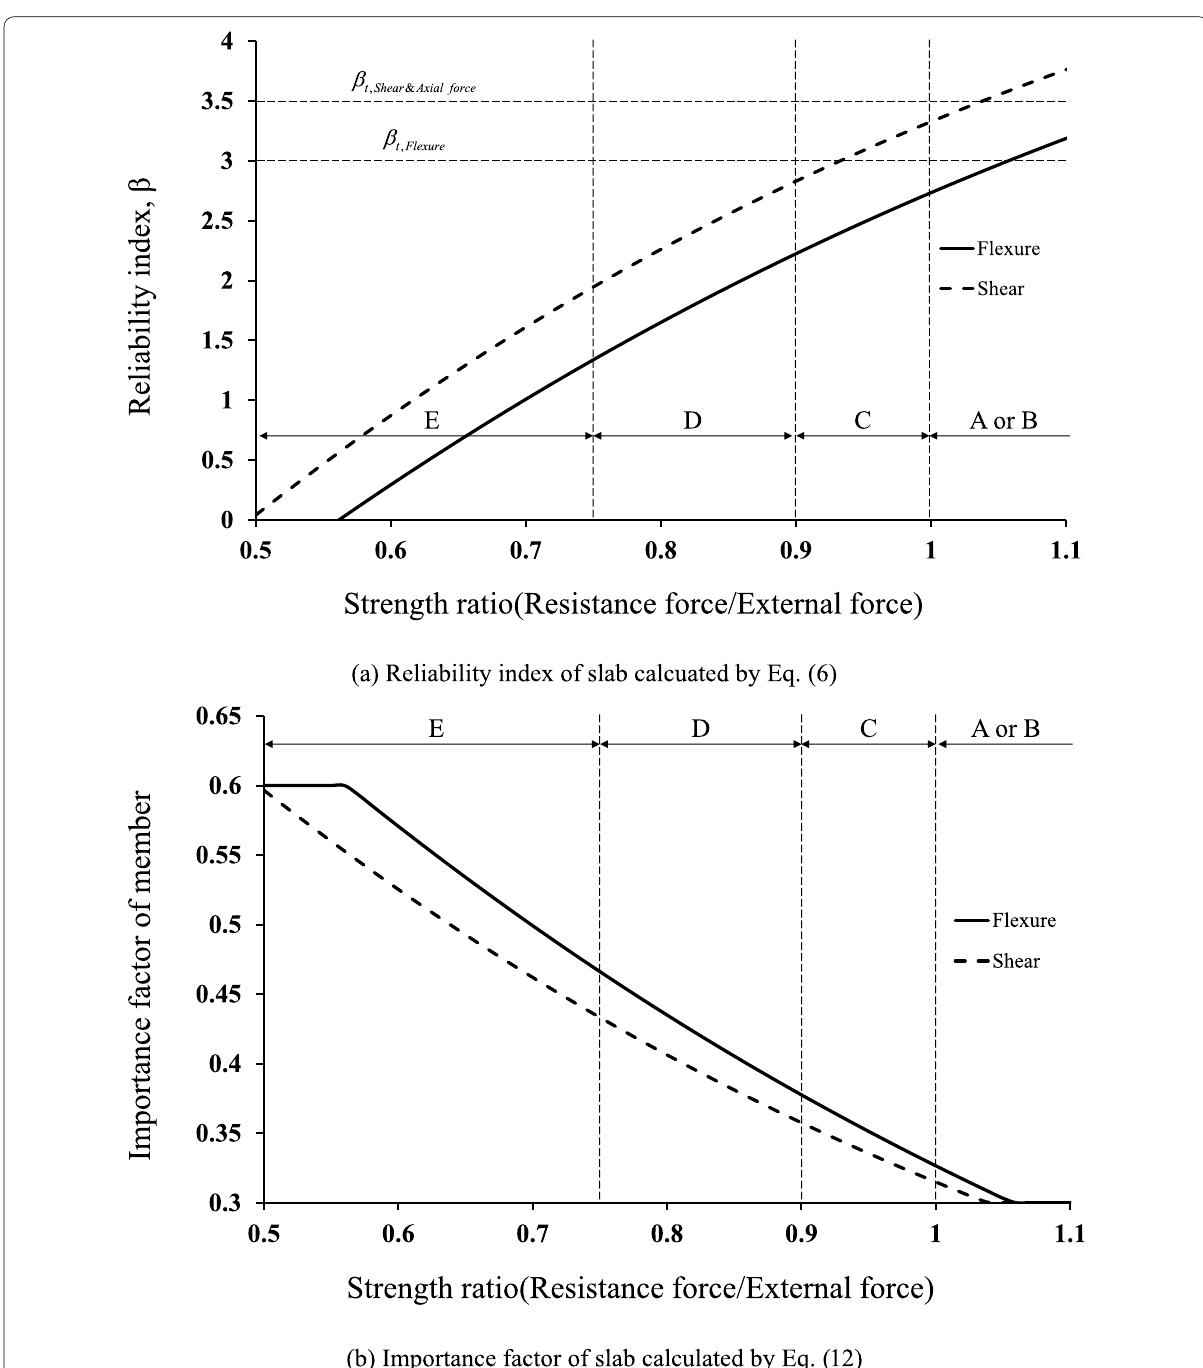
Fig. 5 Relationship between reliability index and importance factor of